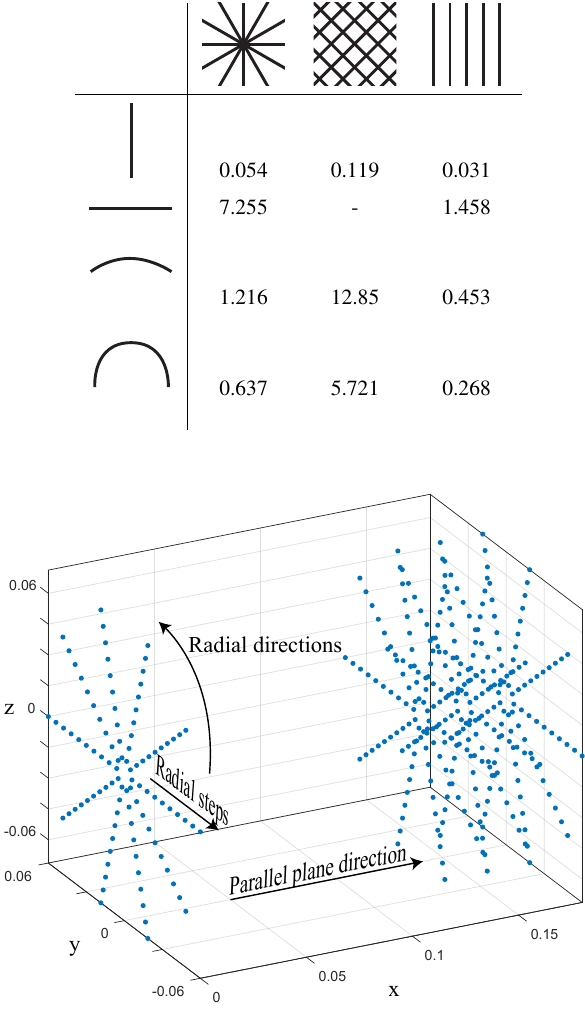
Figure 4. The potential energy of the whole system is evaluated for a multitude of endpoint displacement locations. The set of points is ordered in a radial grid of 70 radial steps along 36 radial directions. This is repeated for a set of 100 equally spaced planes parallel to the yz -plane.